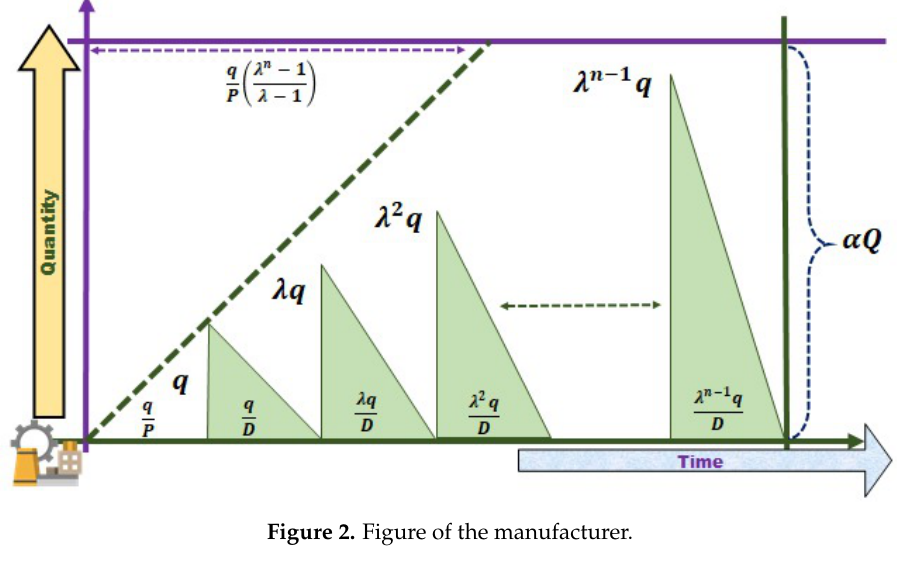
Figure 2. Figure of the manufacturer.